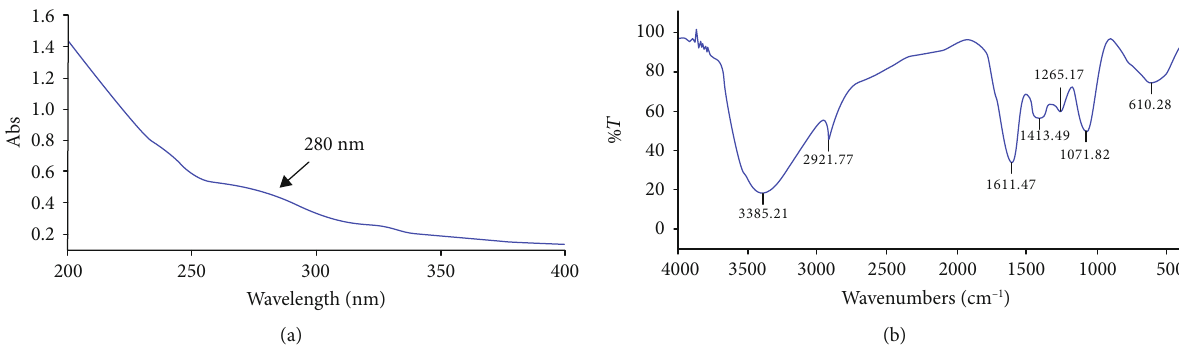
Figure 1: Identi fi cation of CPP in polysaccharides. (a) Ultraviolet spectrum identi fi cation result of CPP; (b) infrared spectrum identi fi cation result of CPP.